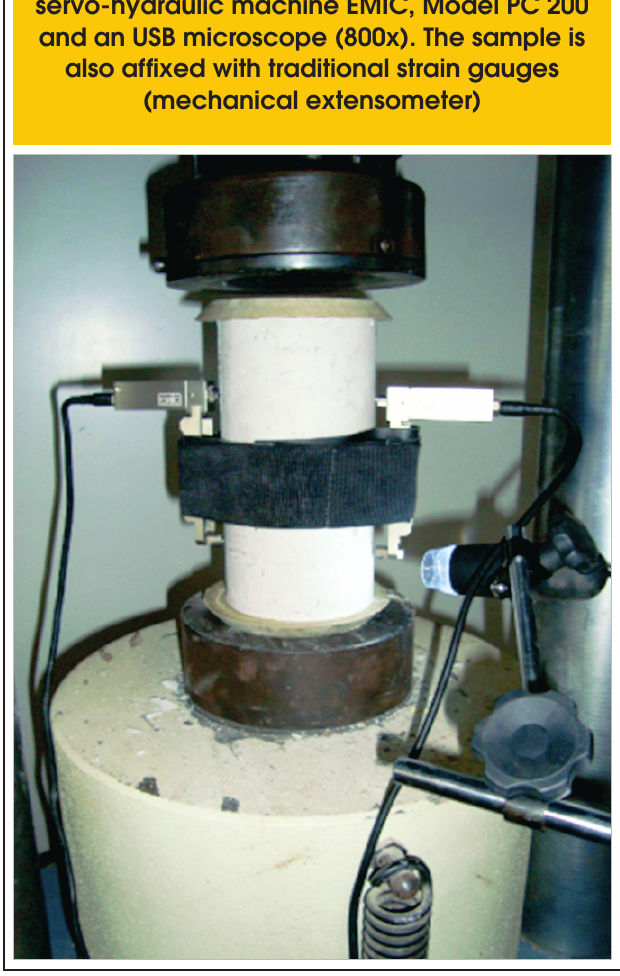
Figure 5 – Real setup of the experiment using a servo-hydraulic machine EMIC, Model PC 200 and an USB microscope (800x). The sample is also affixed with traditional strain gauges (mechanical